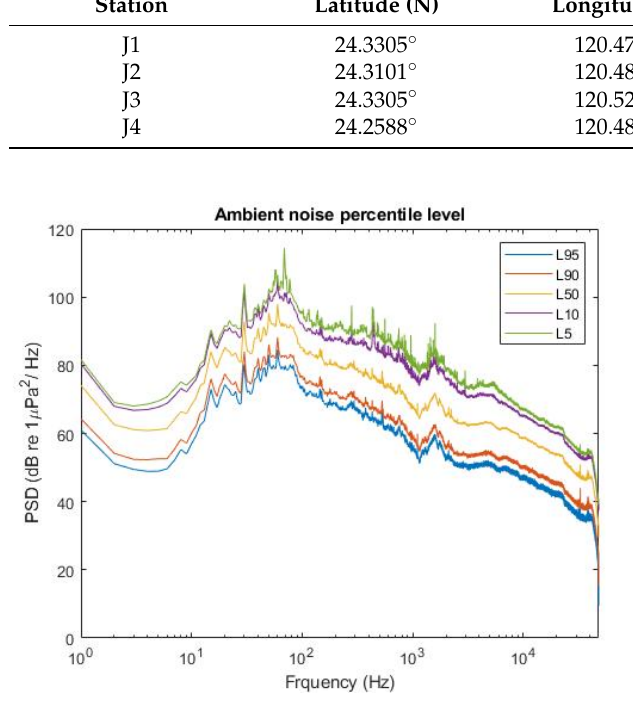
Figure 5. Ambient noise percentile level: Ln is the noise level exceeding n % of the measurement time, i.e., L50 is the noise level exceeding 50% of the measurement time.